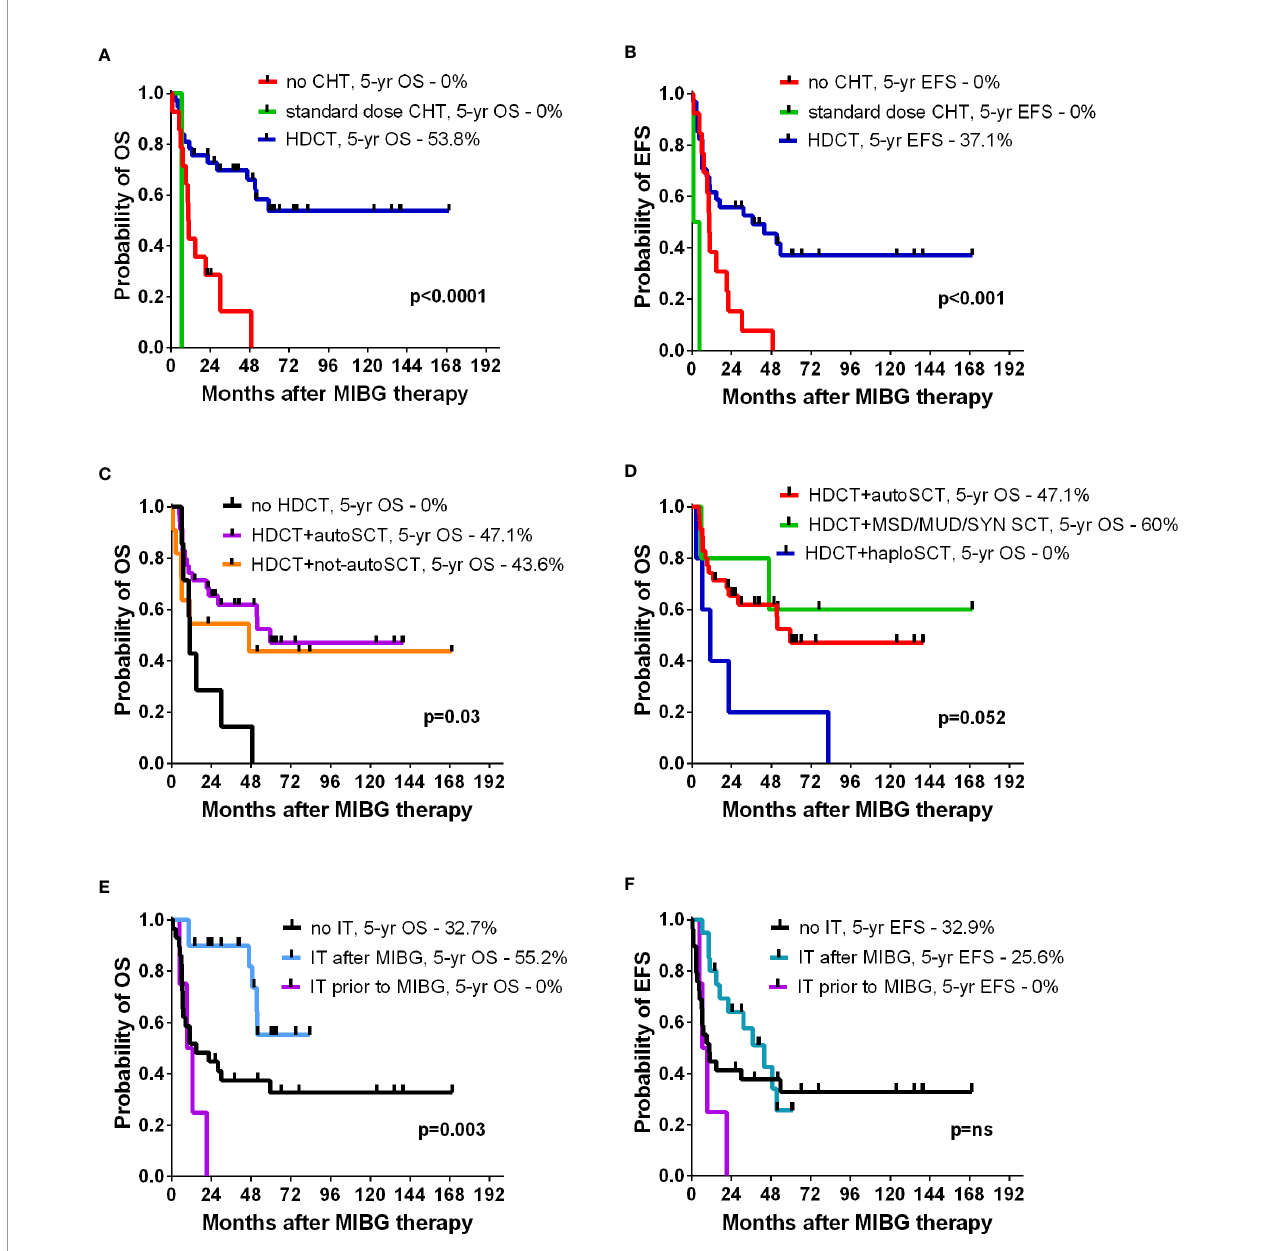
FIGURE 3 | The effect of chemotherapy on OS (A) and EFS (B) . OS in patients with or without HDCT (C) , and impact of different donor types on OS (D) . The effect of immune therapy (IT) on OS (E) , and EFS (F)